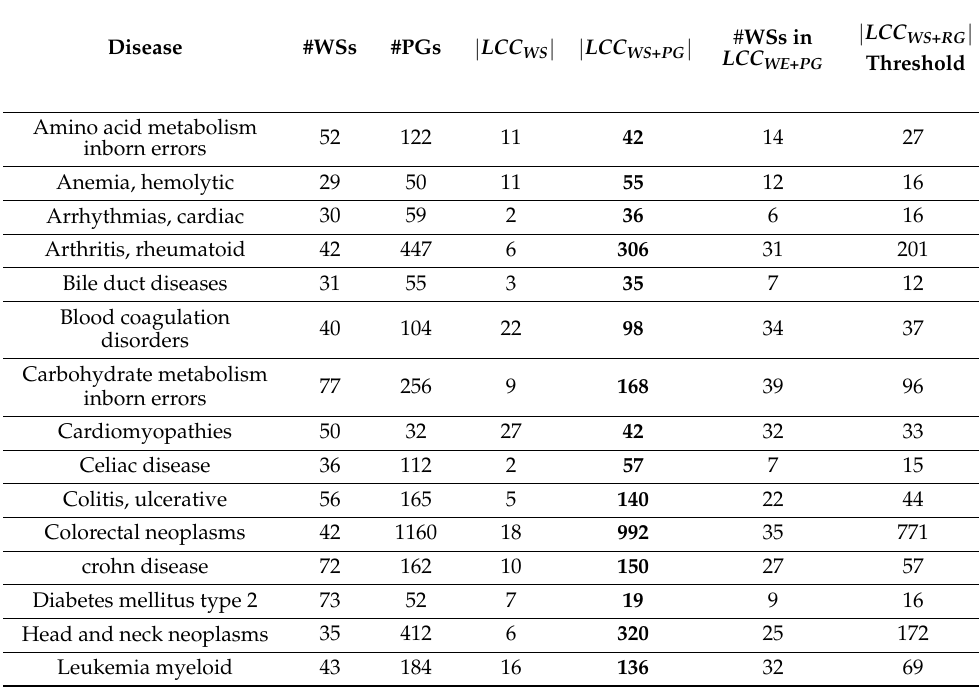
Table 3. Study of the largest connected component (LCC) of the disease module. For each disease, we show the number of warm seeds (WSs), the number of putative disease genes (PG), the size of the LCC consisting of warm seeds only ( | LCC WS | ), the size of the LCC considering the set S 0 ∪ PG ( | LCC WS + PG | ) , the number of warm seeds in LCC WS + PG , the 95th percentile threshold of the distribution of the 1000 LCCs of the random disease module (known disease genes and random genes). In the column | LCC WS + PG | , bold text highlights values above | LCC WS + RG |